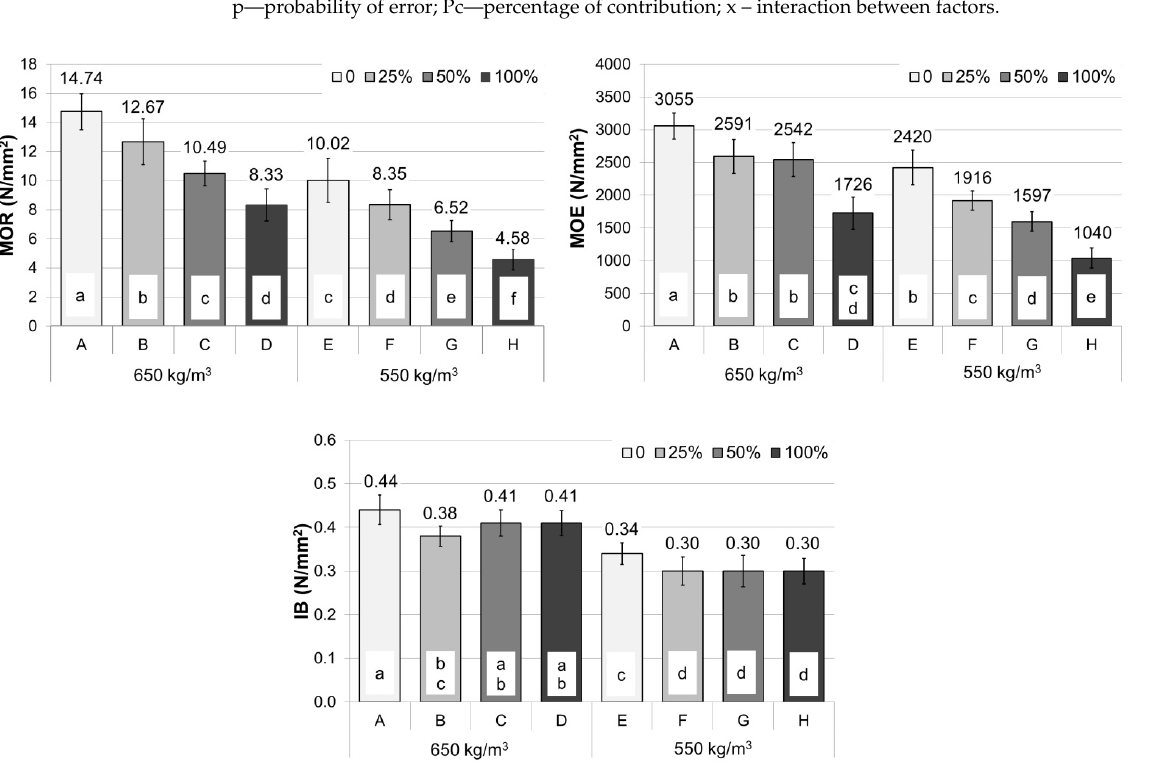
Figure 3. Mechanical properties of particleboards, a–f correspond to the homogeneous groups by Tukey test ( α = 0.05).